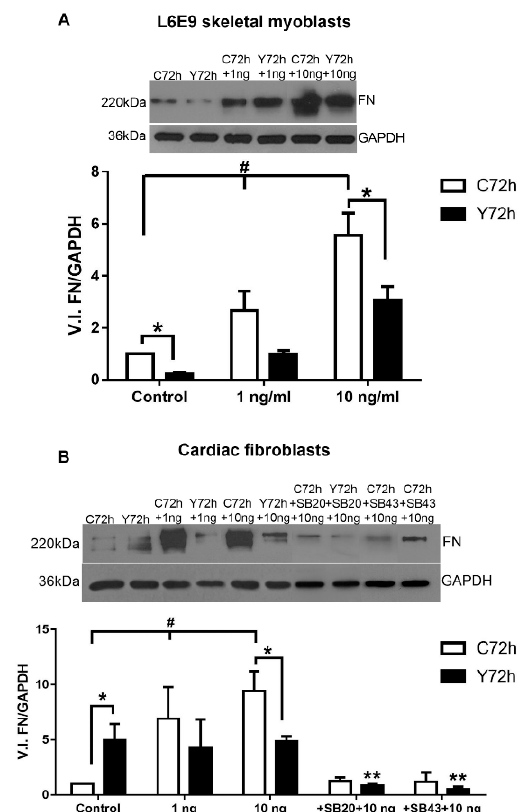
Figure 3. Fibronectin expression in L6E9 skeletal myoblasts and cardiac fibroblasts treated with TGF- β . ( A ) In normal cultures, treatment with 1 ng / mL TGF- β for 48 h triggered the increase of FN expression in L6E9 skeletal myoblasts in a dose-dependent manner after the addition of 1 and 10 ng / mL TGF- β . In L6E9 skeletal myoblasts infected with T. cruzi (72 h) and treated with TGF- β (1 and 10 ng / mL) an increase of FN expression was observed when compared with the infected and untreated cultures, treatment with TGF- β (1 and 10 ng / mL). * p ≤ 0.05 compared to uninfected pairs; # p ≤ 0.05 compared